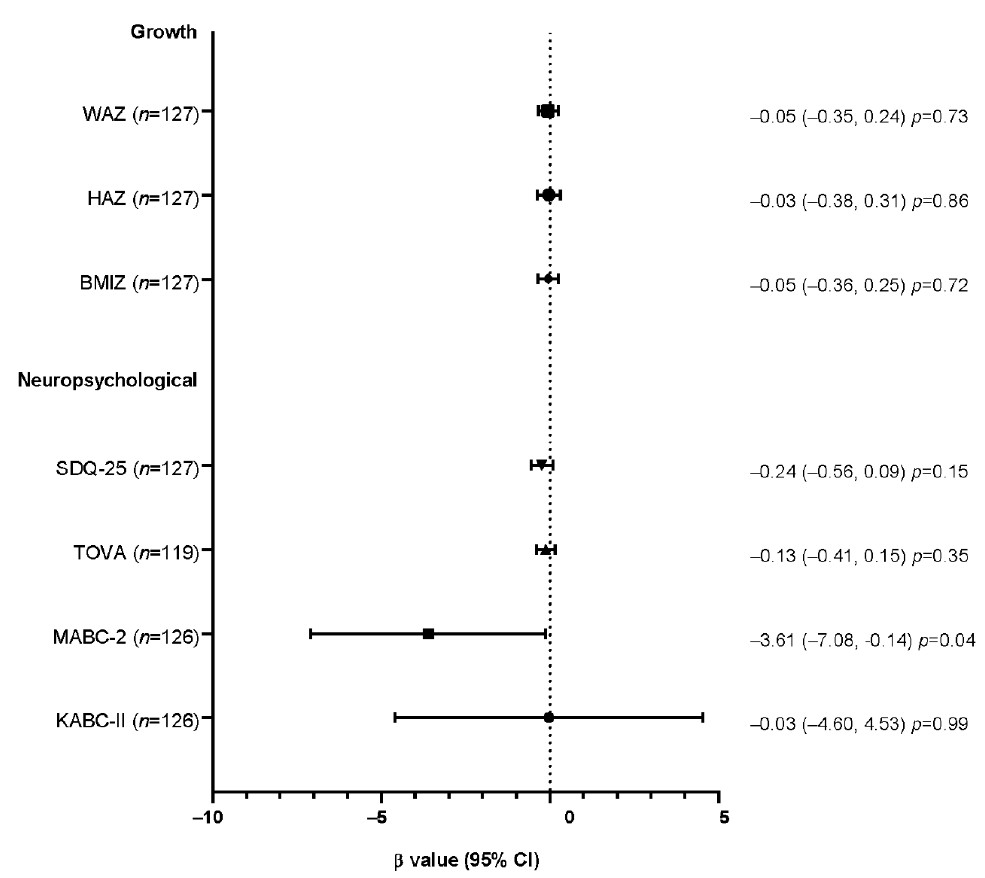
Figure 1. Forest plot of the association between growth and neuropsychological outcomes at year-6 with telomere shortening at week-50, assessed by linear regressions.